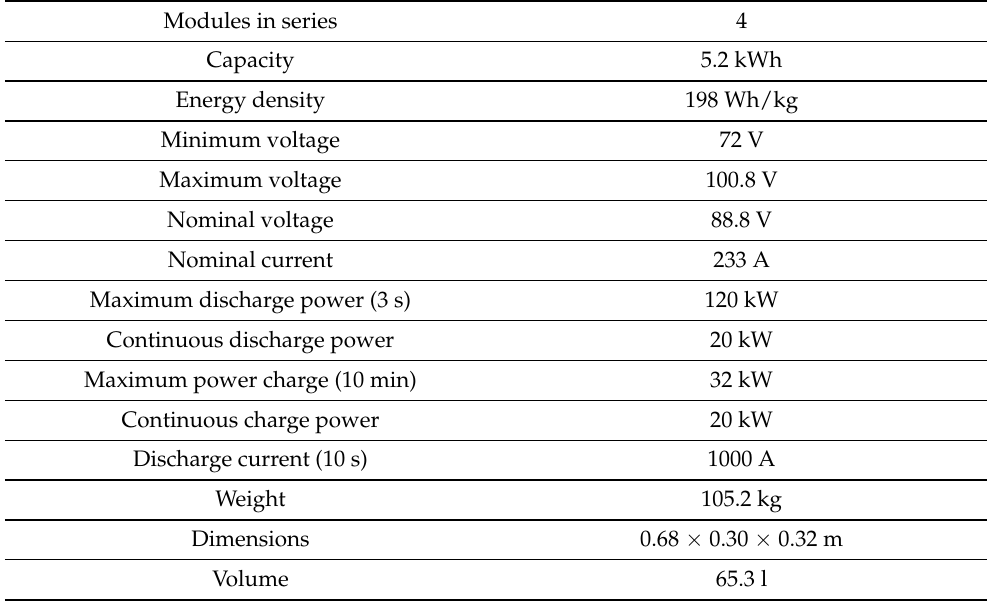
Table 3. Backhoe battery bank